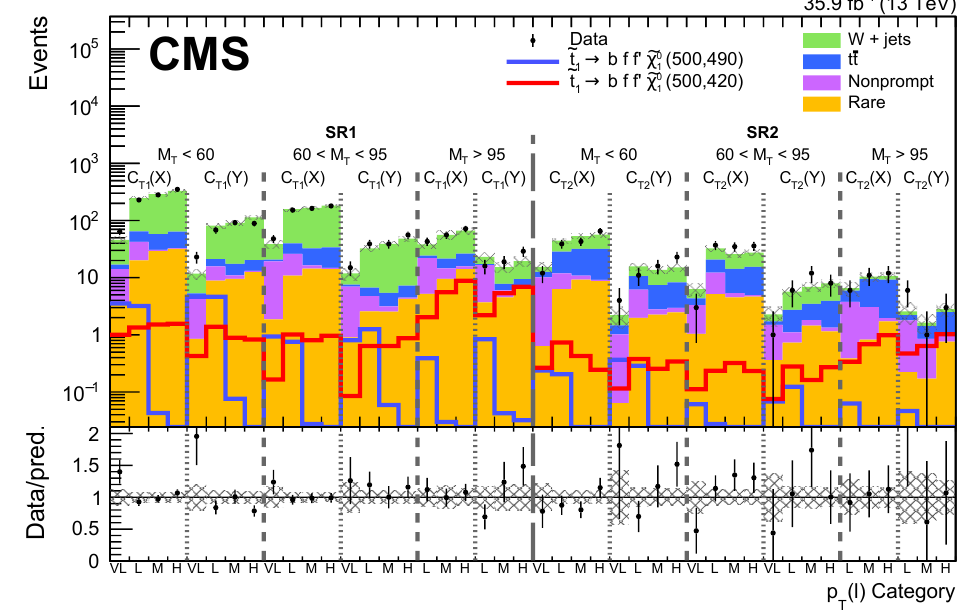
Figure 6 . The CC approach: summary of observed and expected background yields in all SRs as de(cid:12)ned in table 1. The vertical bars and the shaded areas represent the statistical uncertainty of the data and the total uncertainty in the prediction, respectively. The lower panel shows the ratio of data to prediction.